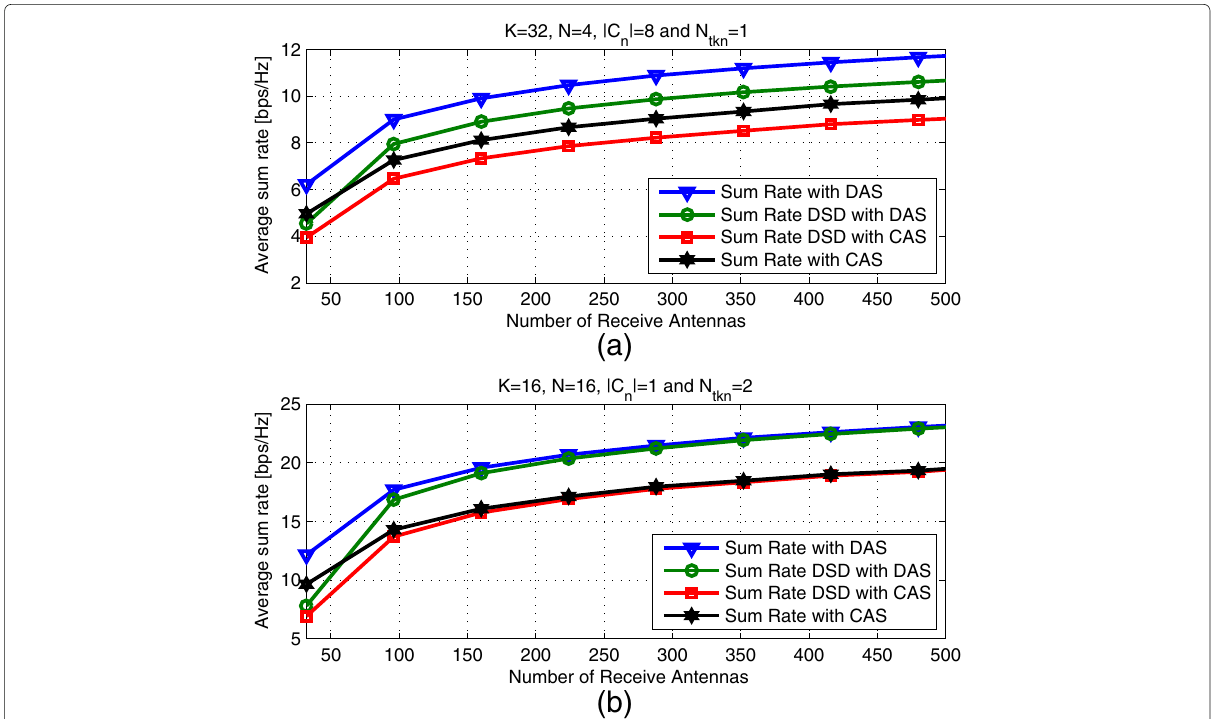
= 1 antenna per user. b Sum rate vs number of receive k , n